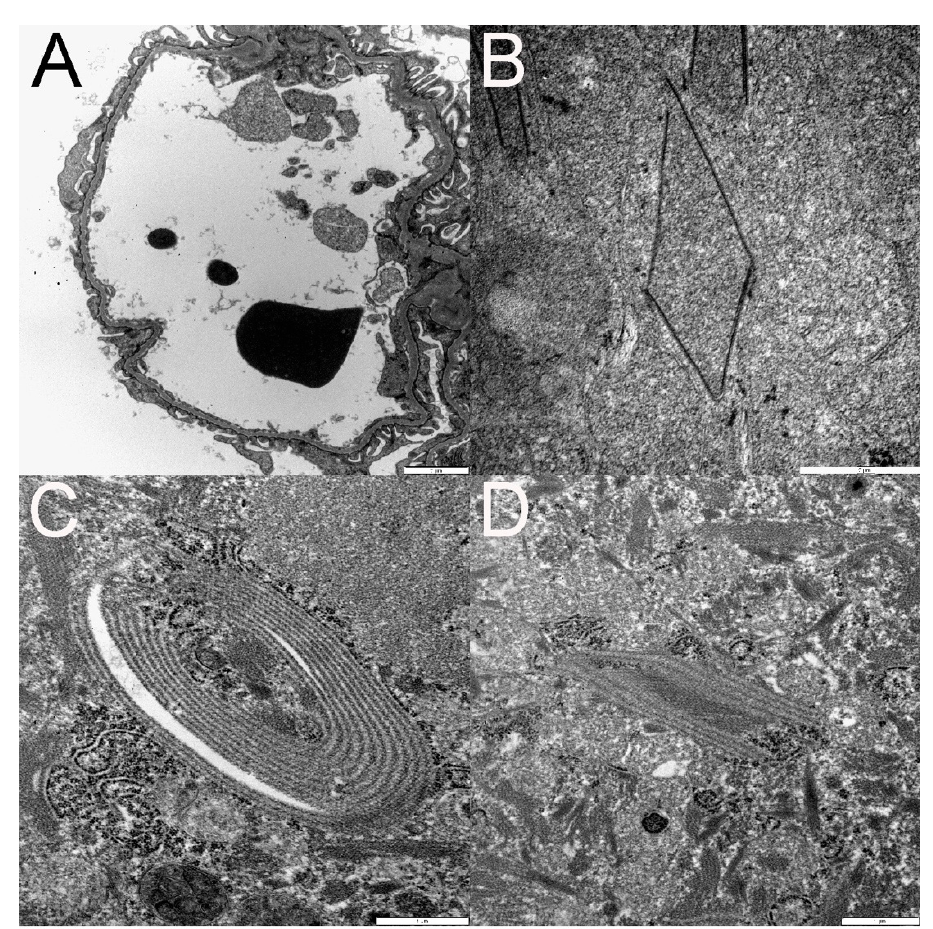
Figure 6. Transmission electron microscopy (TEM) documents podocyte foot process effacement ( A ). Examples of organized linear structures in tubular epithelial cell cytoplasm are depicted in panels B – D . These structures ranged from polygonal ( B and D ) to ovoid ( C ). Some structures were composed of a single electron dense line ( B ), whereas others were composed of numerous parallel electron dense lines ( C and D ) separated by regularly spaced electron lucent lines ( C and D ).